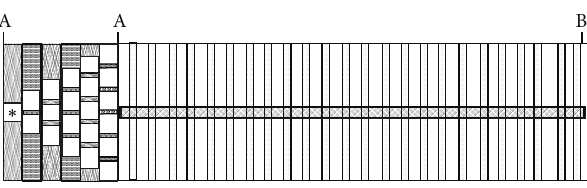
Figure 26: Simplest scheme of generator of plane wave and DDT